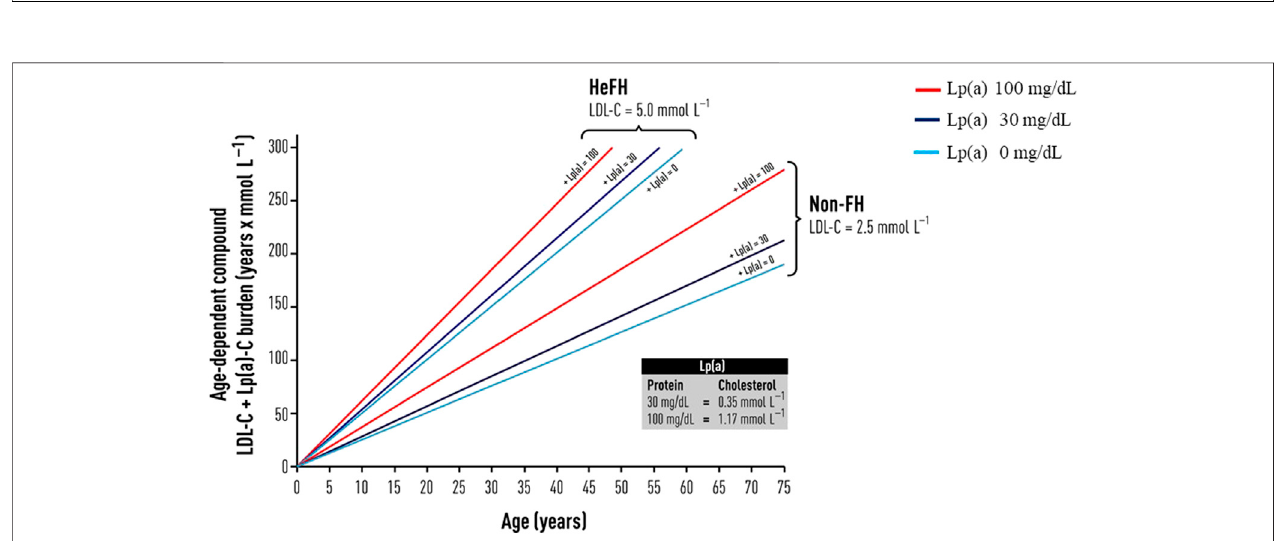
FIGURE 3 | Schematic diagram of the concept of compound LDL- and Lp(a)--cholesterol burden ( y -axis) that increases with age, in patients with and without FH, withassumptionthatinuntreatedheterozygousFHpatients(HeFH)andinnon-FHindividuals.FromVuorioA,WattsGF,SchneiderWJ,TsimikasS,KovanenPT.Familial hypercholesterolemia and elevated lipoprotein (a): double heritable risk and new therapeutic opportunities. J. Intern. Med. 2020; 287:2 – 18, with permission.